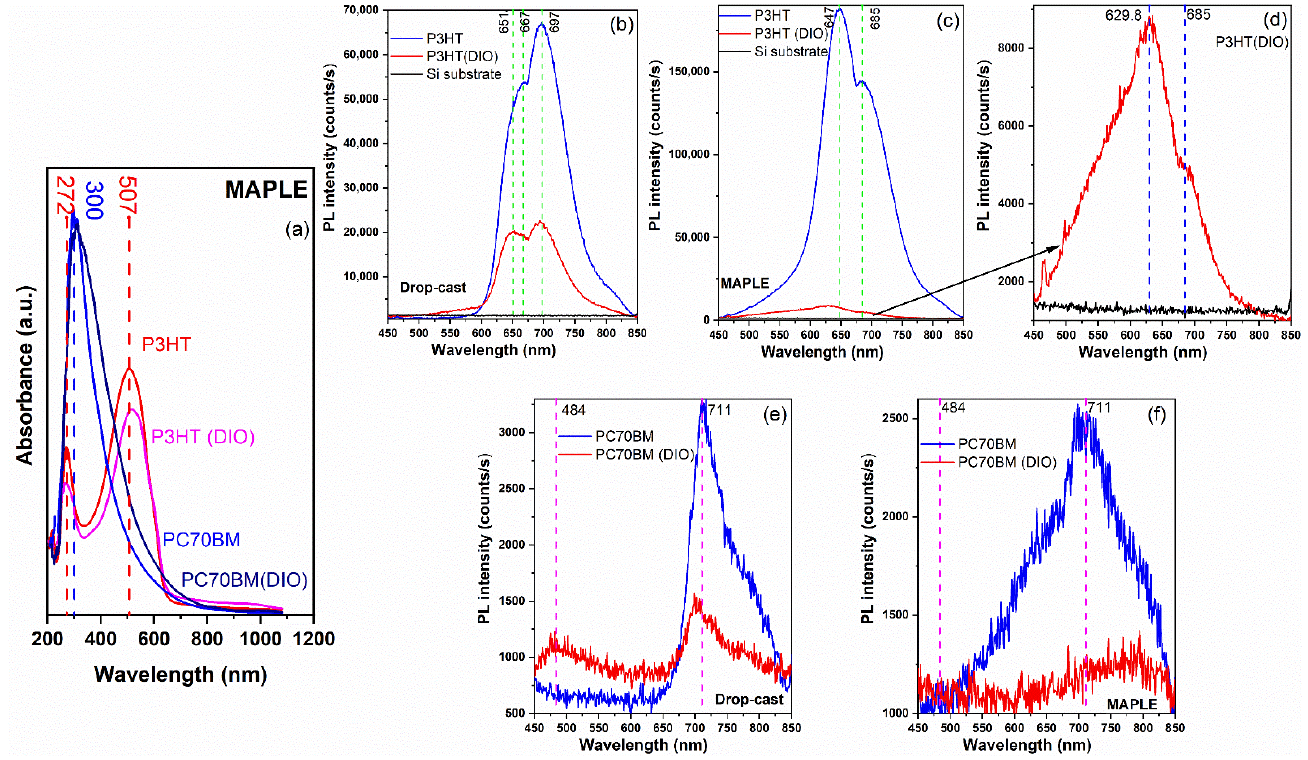
Figure 6. ( a ) UV-VIS and ( b – f ) PL spectra of the P3HT and PC70BM thin films deposited by MAPLE ( a , c , d , f ) and drop-cast ( b , e ) with and without DIO on glass and silicon substrates, respectively.